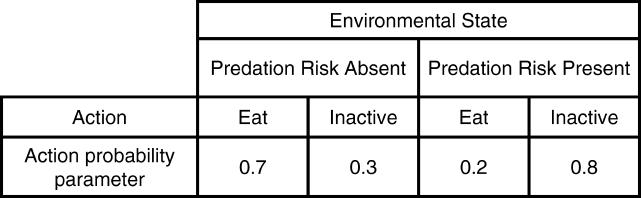
Action Probability Parameters that Determine the Behavioral Strategy for a Single Individual PP-ConsumerThere are two possible actions for each environmental state (i.e., different predation risks). In this example, the consumer has a 70% probability of performing the eat action (which can include moving to a neighboring cell) if the predator is absent, but 20% if the predator is present. Note that animals from the same species would have the same set of action probability parameters that determine the behavioral strategy, but the probability magnitudes may differ. Behavioral strategies with higher fitness will be selected and therefore “evolve” over time.